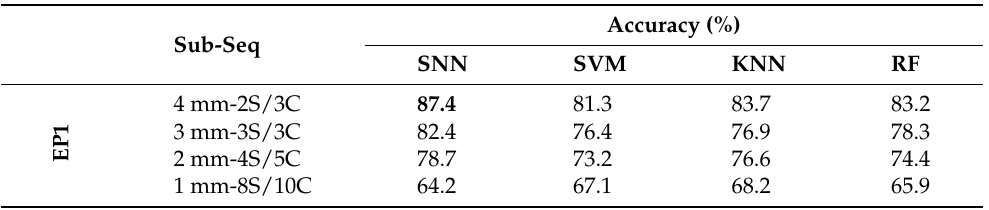
Table 2. Cross-validated binary class accuracies for straight/curved path prediction using EP specific subsequences. S—straight path, C—curved path.